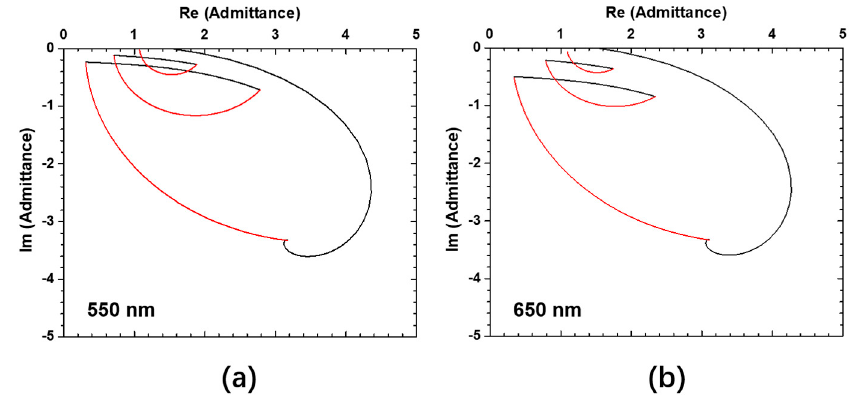
Figure 3. ( a ) The optical admittance diagram at 550 nm incident light; ( b ) the optical admittance diagrams at 650 nm incident light.